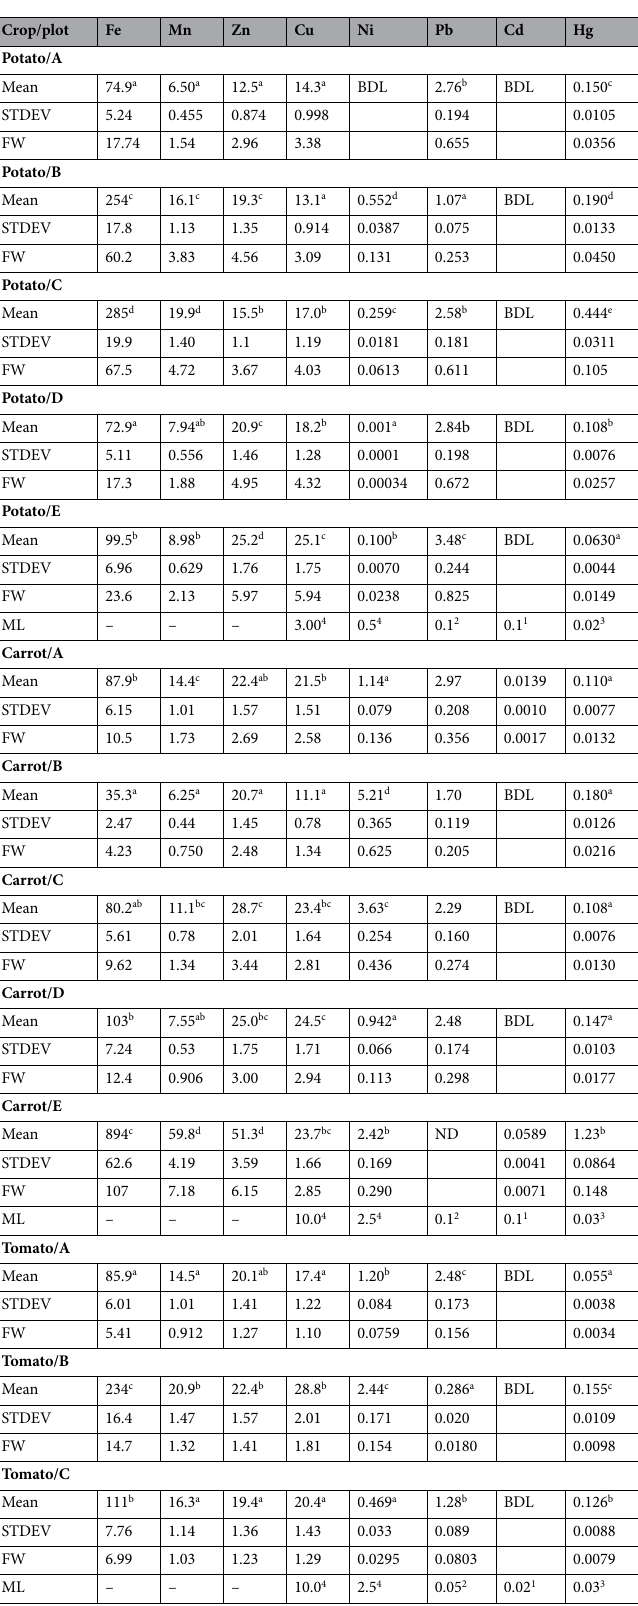
Table 8. The content of heavy metals in plant materials (mg/kg DW). DW dry weight, FW fresh weight (mg/ kg), ML maximum levels (mg/kg FW), BDL below detection limit. 1 According to EU 32 . 2 According to EU 33 . 3 According to Regulation SR 34 . 4 According to Regulation SR 35 . a–e Statistically significant differences between plots, P value < 0.0 of One-Way ANOVA